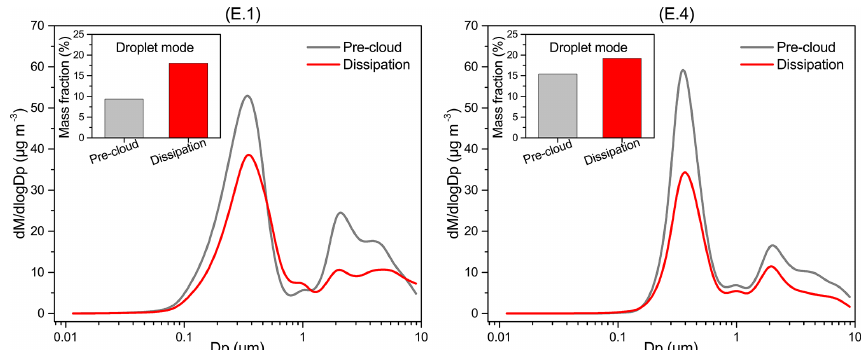
Figure 10. Average mass size distributions of aerosol particles during the pre-cloud and dissipation periods for cloud events E.1 and E.4. Embedded graphs show the droplet-mode fraction of the total mass. A particle density of 1.65µgm − 3 was used in this study. dM represents the mass concentration of the particles in each size bin, and Dp is mobility